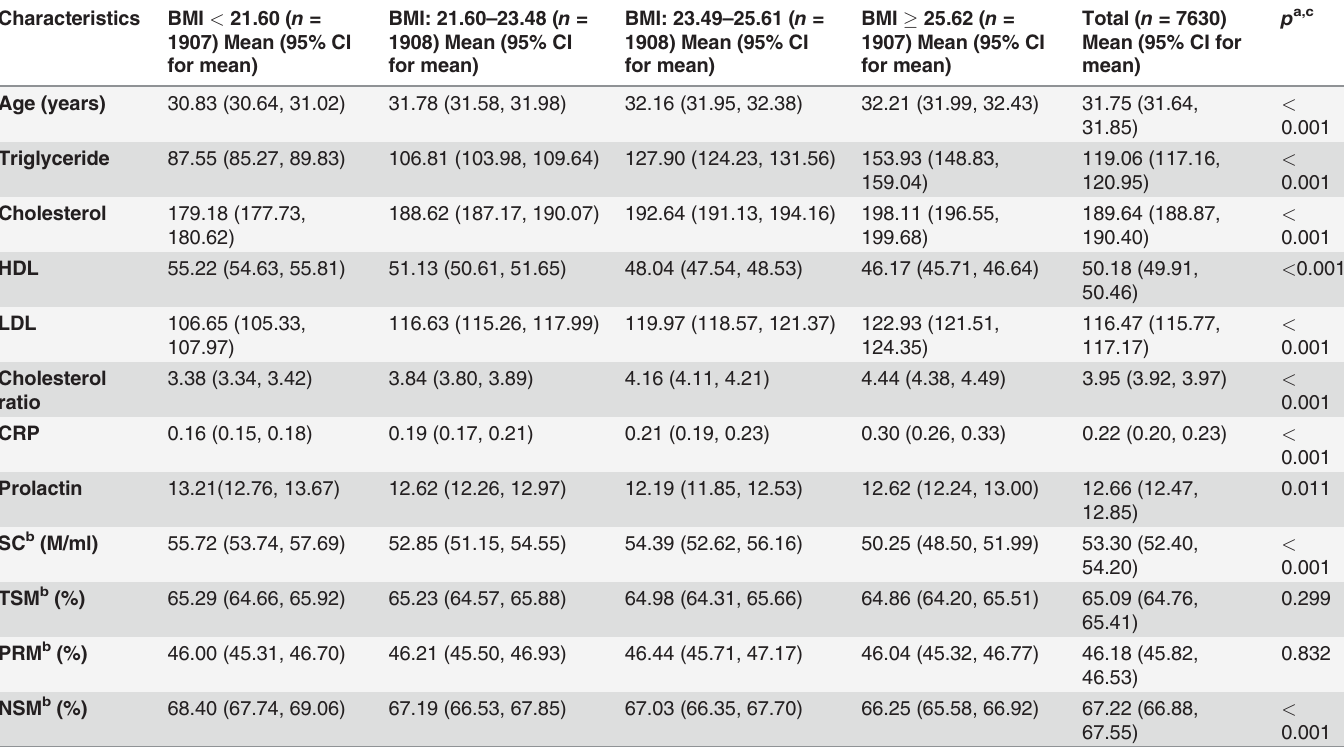
Table 1. Characteristics of the general male population ( n = 7630).